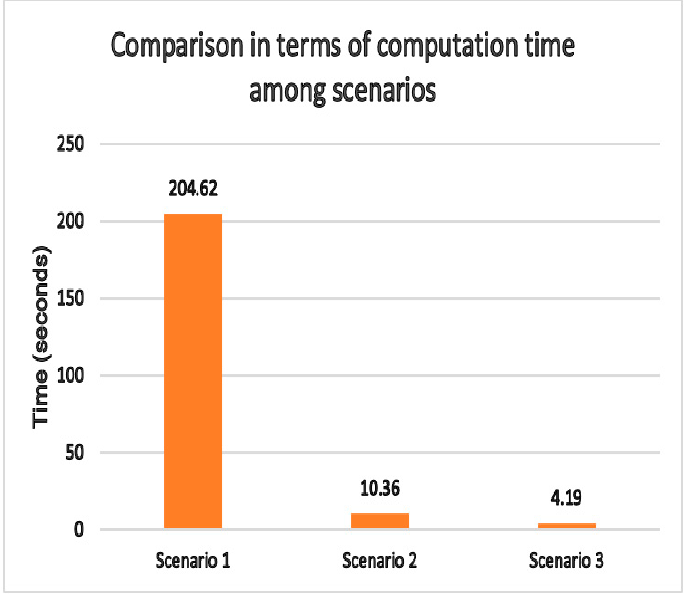
Figure 4. Comparison in terms of computation time among scenarios.